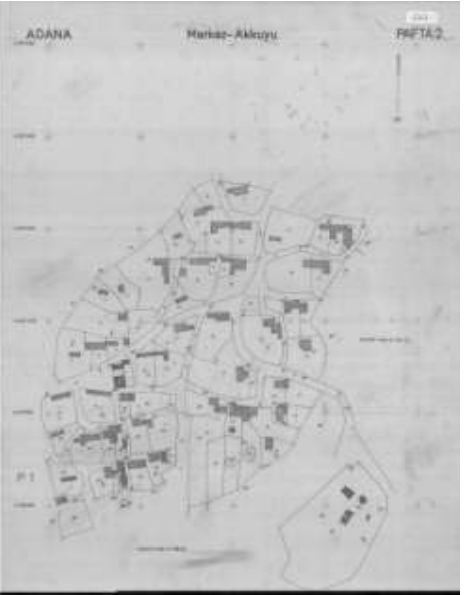
Figure 4. Polar and prismatic map as an example